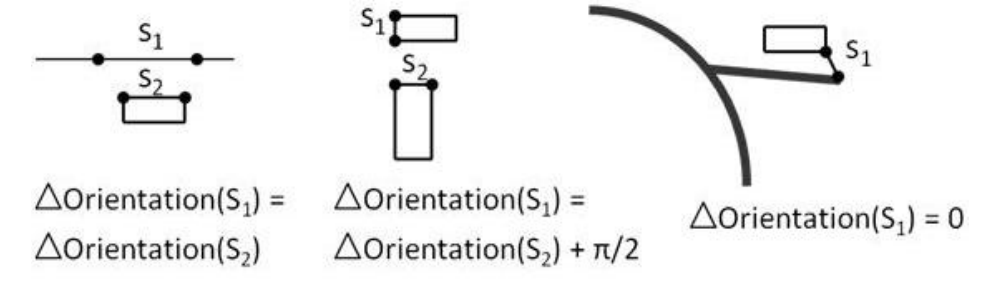
Figure 12. Constraint expression of the preservation of relative orientation and position